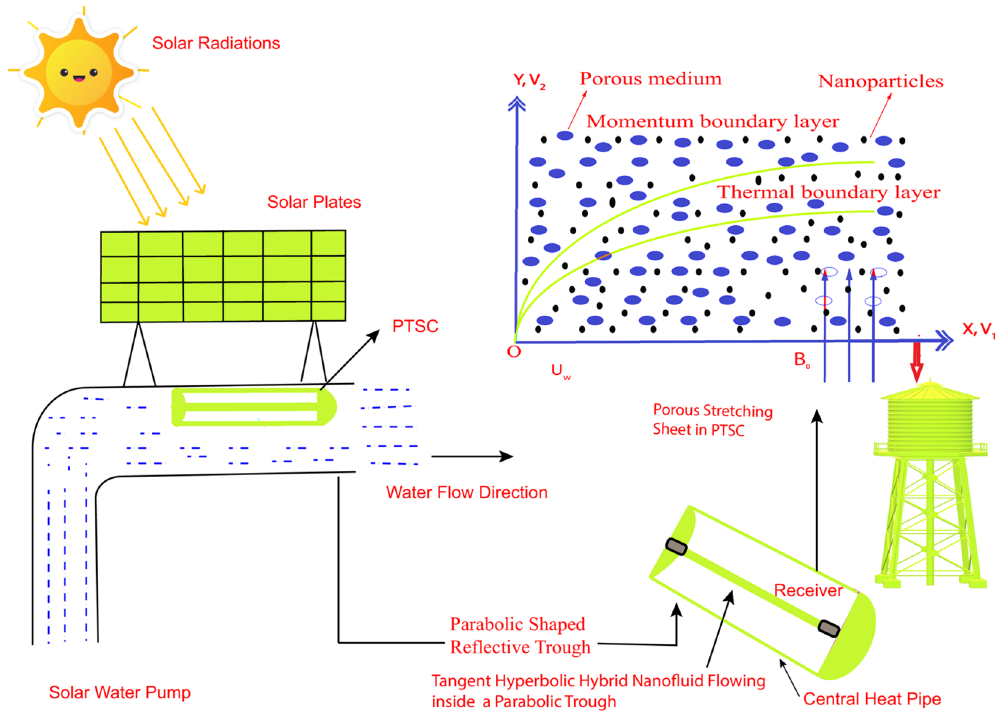
Figure 1. The theoretical experiment of a solar water